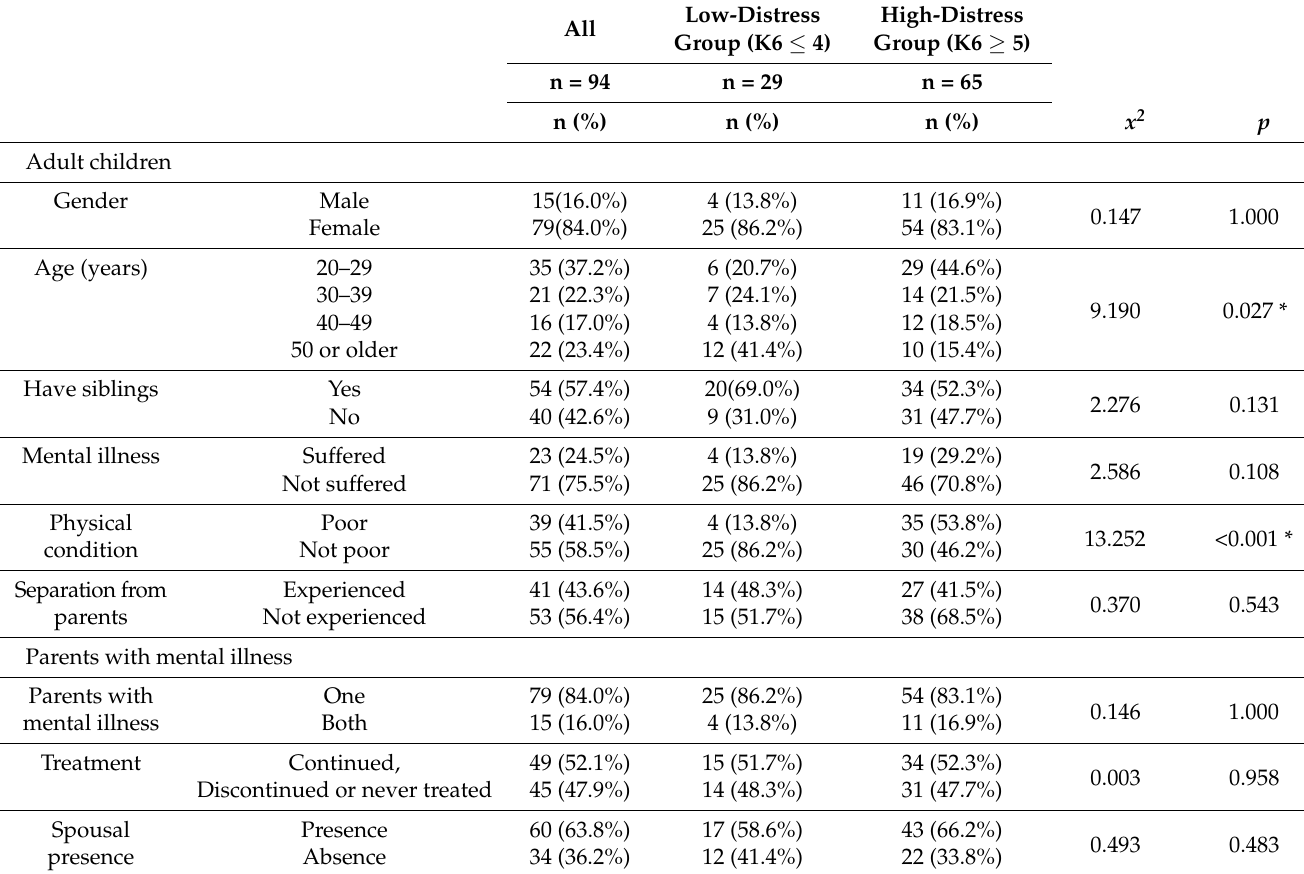
Table 1. Demographic data of adult children from the high- and low-distress groups. All Group (K6 ≤